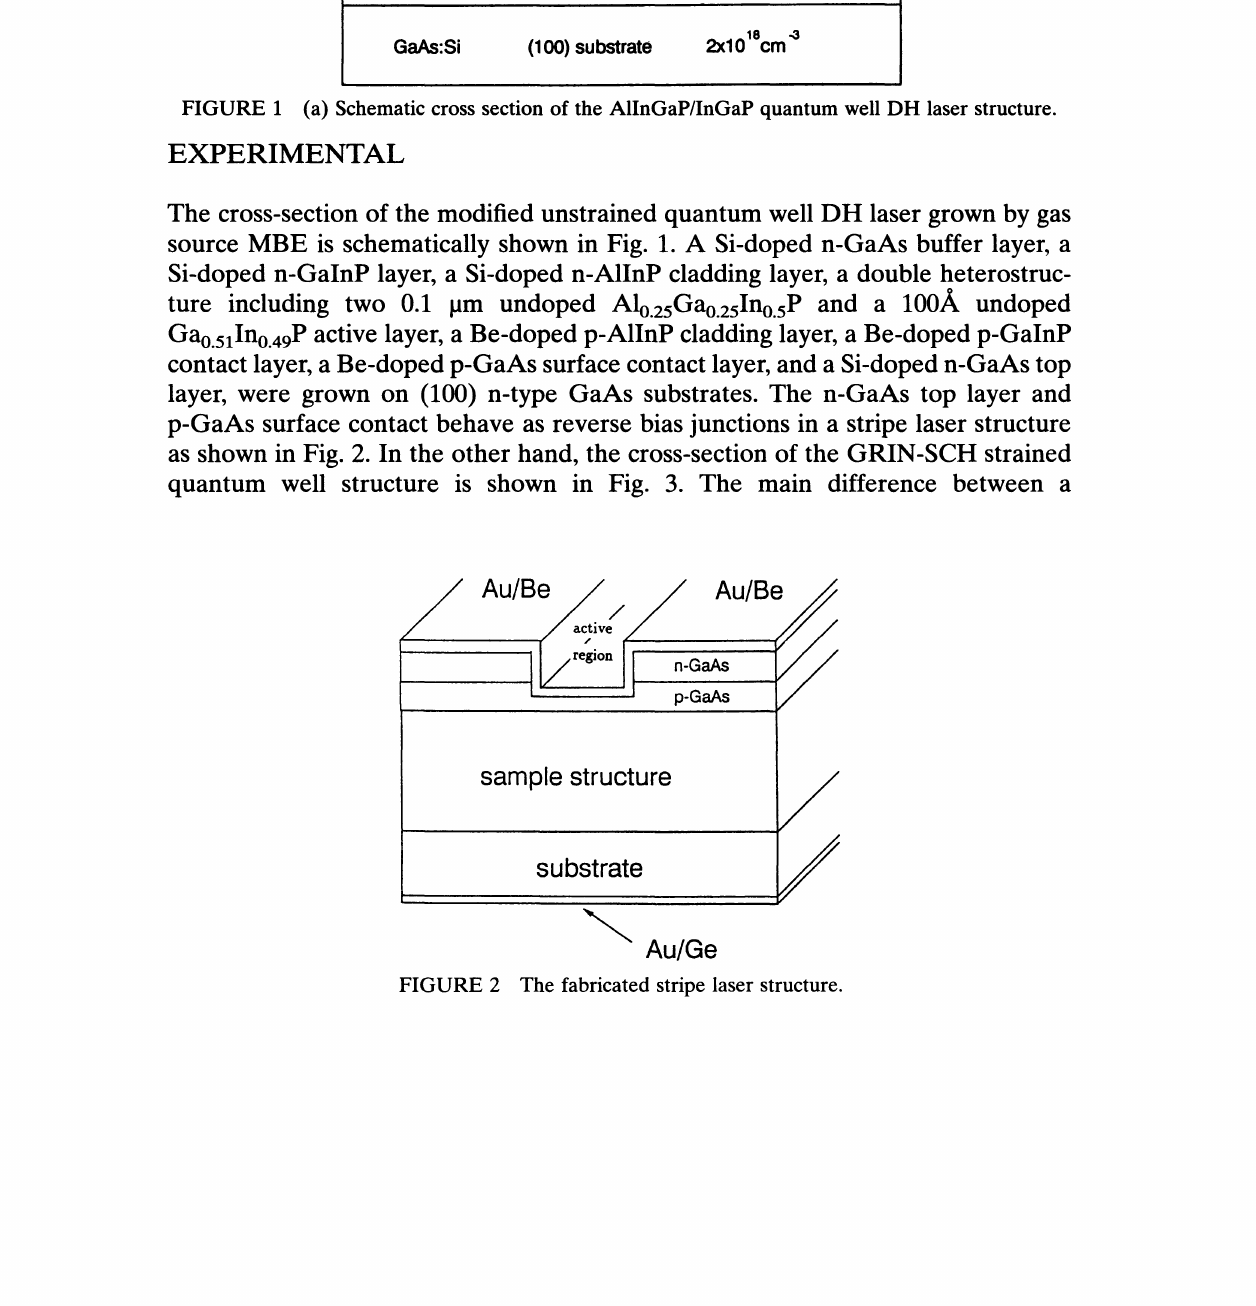
FIGURE 1 (a) Schematic cross section of the AIlnGaP/InGaP quantum well DH laser structure.